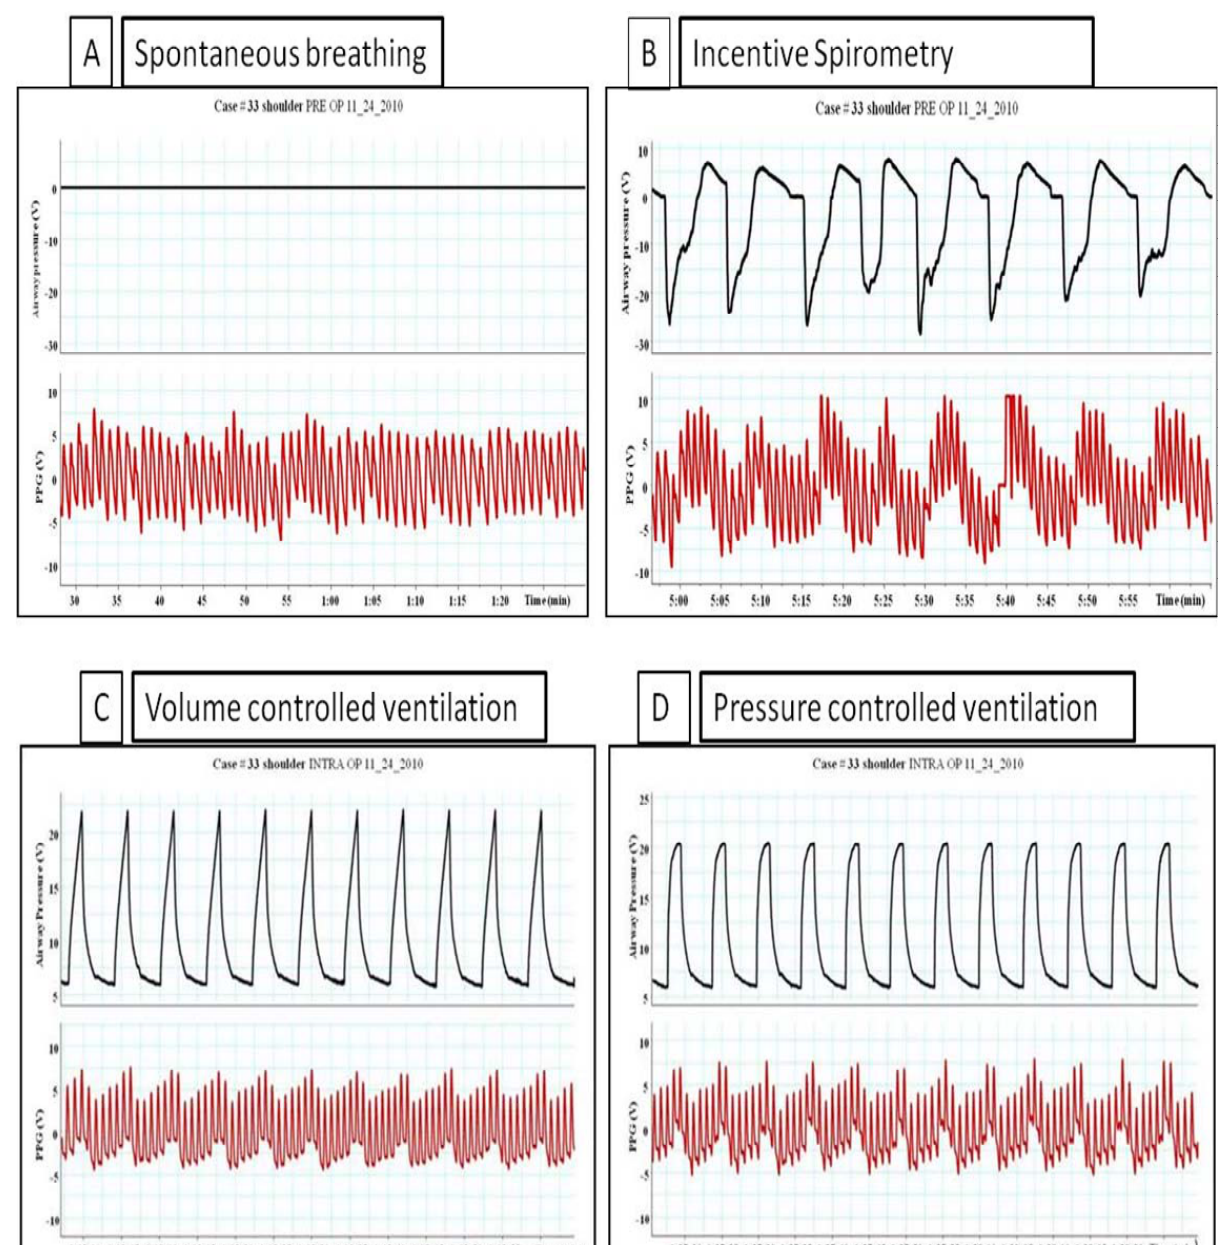
Figure 7. The impact of ventilation on PPG waveforms. ( A ) Spontaneous breathing, ( B ) Incentive spirometry breathing with negative airway pressure around 20 cm H ( C ) Volume controlled mechanical ventilation ( D ) The impact of pressure controlled mechanical on the PPG